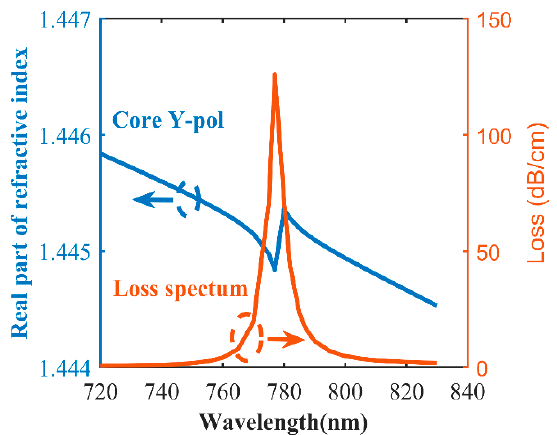
Figure 6. Real part of effective refractive index of the y-polarized fiber core mode, and the loss spectra of the PCF-SPR sensor when the material of the metal layer is silver .